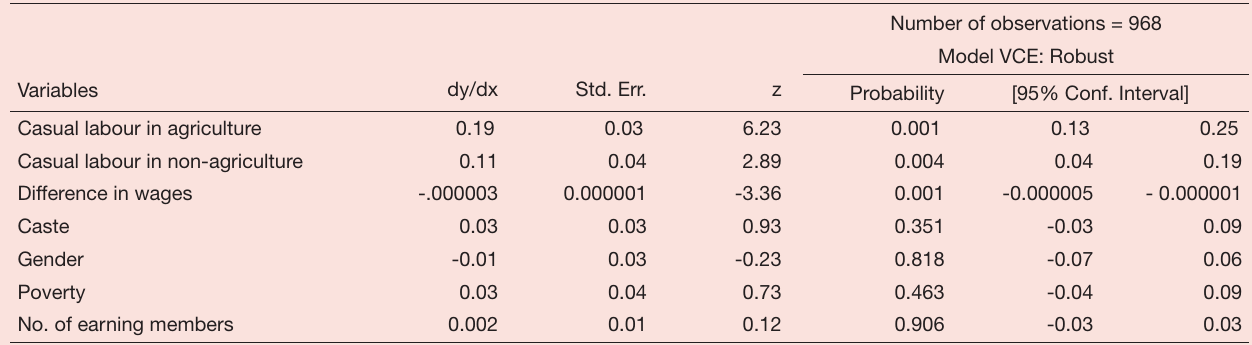
Table 1: Results of Probit model – average marginal